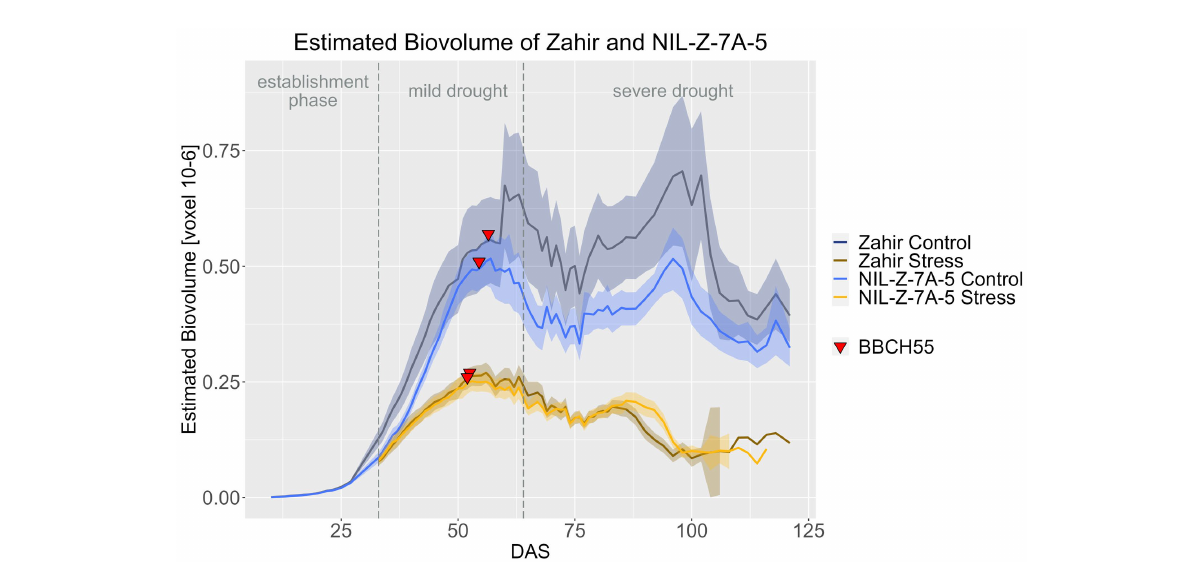
FIGURE 6 Estimated biovolume of Zahir and NIL-Z-7A-5 based on the calculated BLUEs values. DAS, days after sowing; BBCH55, heading day. The last DAS for each genotype was chosen for the DAS where the last time 60% of the plants were imaged (as mature plants were taken off subsequently). The shadows describe the confidence interval; as long as the shadows of the individual lines do not overlap, the significance level of a = 0.05 is not reached and therefore a significant difference exists.